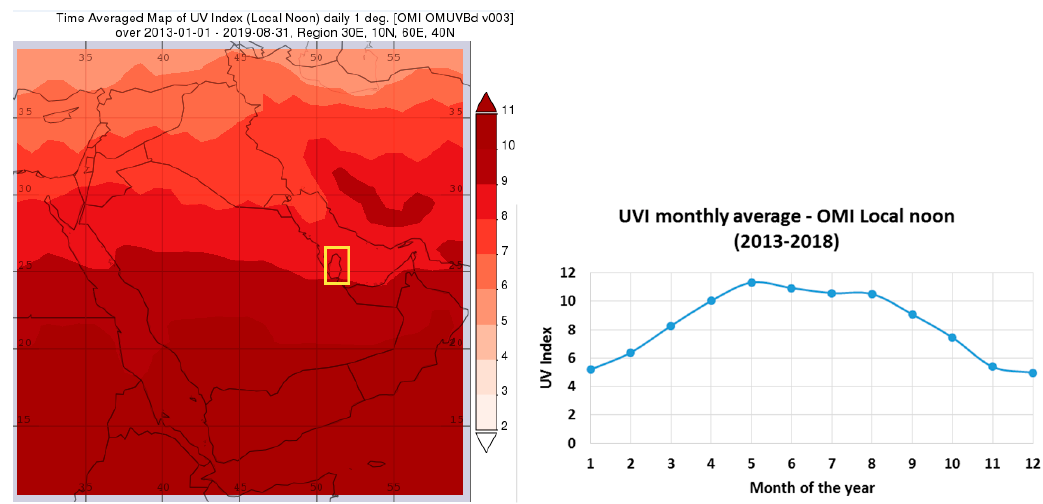
Figure 8. ( left ) Map of UV Index across the Arabian Peninsula from 1 January 2013 to 31 August 2019. The yellow box locates Qatar at latitude of 24.08–26.35 and longitude 50.62–51.88 (NASA, OMIUVb data retrieved from NASA’s GIOVANNI platform); ( right ) Monthly variation of UV Index over Doha, Qatar as obtained from NASA’s OMI satellite.